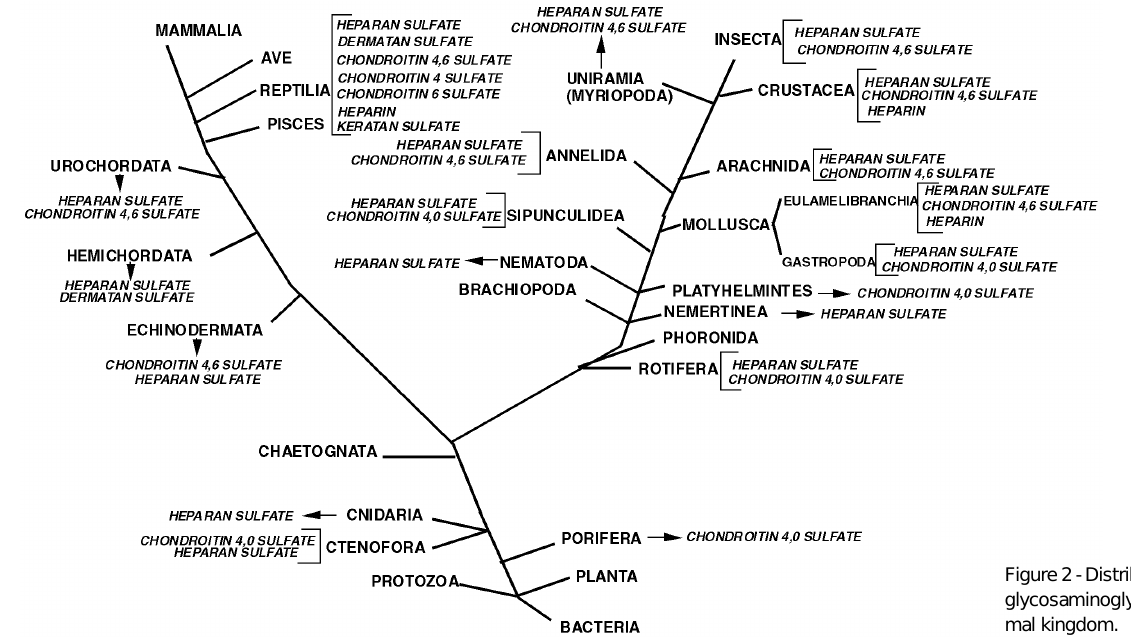
Figure 2 - Distribution of sulfated glycosaminoglycans in the ani- mal